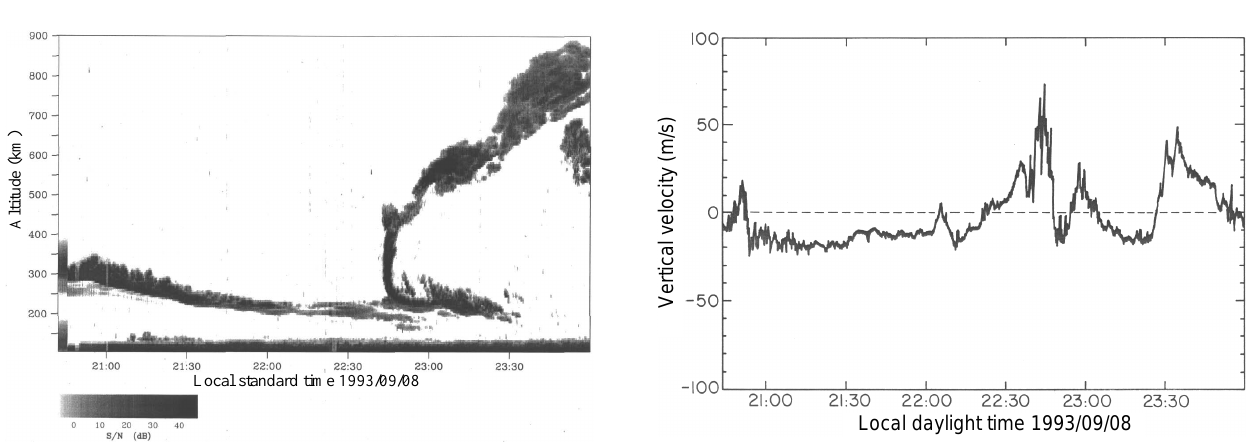
Figure 1. Range–time–intensity plot of spread-F irregularities on 8 September 1993. The C-shaped structure appears at 22:45LT. The level of magnetic activity during the event is low (Kp = 2).